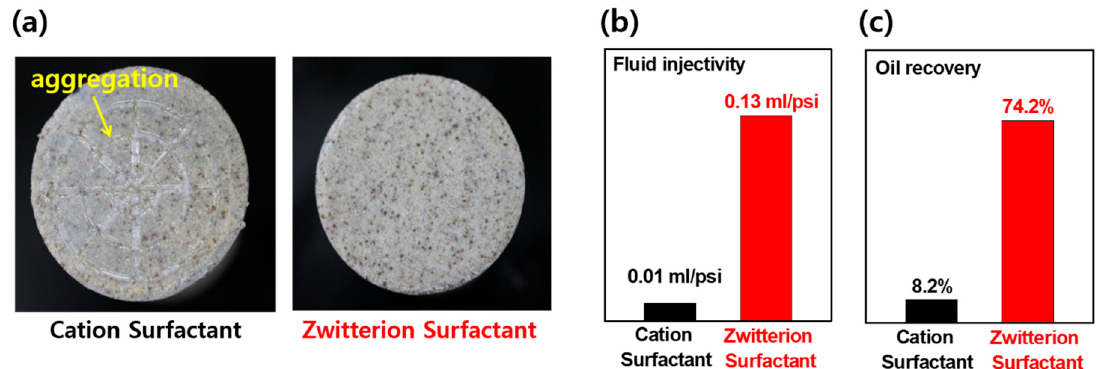
Figure 6. ( a ) Particle aggregation at sandstone inlets on injection of colloidal dispersions containing a cationic surfactant. Reduced ( b ) fluid injectivity and ( c ) oil recovery attributable to aggregation.